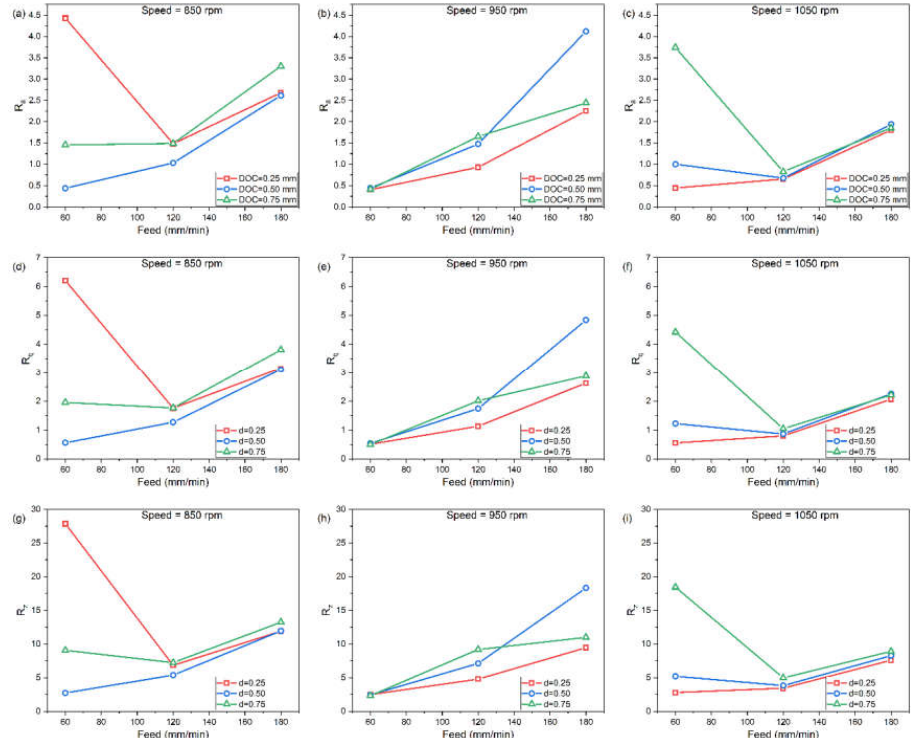
Figure 3. Influence of feed and depth of cut on surface roughness at various speeds. Effect on Average Roughness at speed ( a ) 850 rpm, ( b ) 950 rpm ( c ) 1050 rpm; Effect on RMS Roughness at speed ( d ) 850 rpm, ( e ) 950 rpm ( f )1050 rpm; Effect on Average Maximum Height of the Profile at speed ( g ) 850 rpm, ( h ) 950 rpm ( i )1050 rpm.